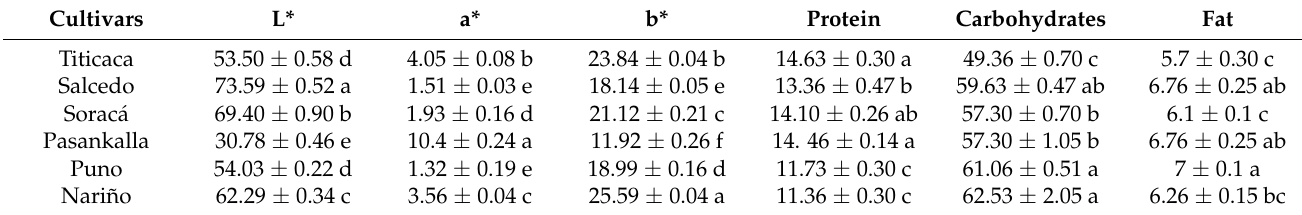
Table 1. Physical–chemical characteristics in Colombian quinoa grains.